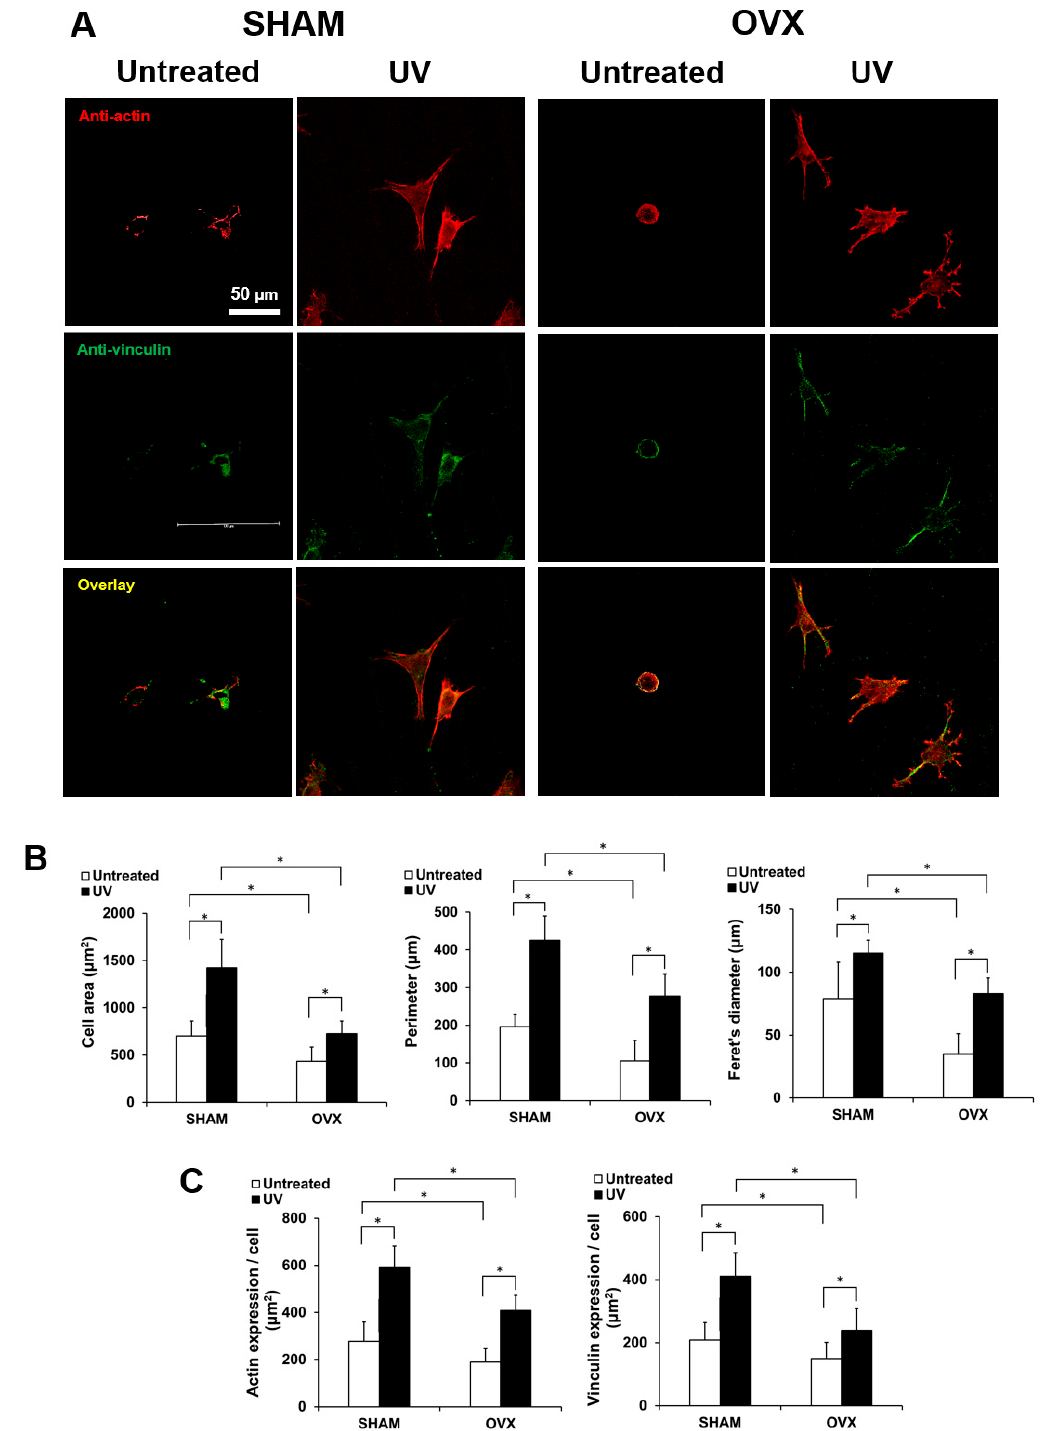
Figure 3. Representative confocal microscopy images of the spreading behavior of osteoblasts from sham and OVX groups at 24 h after seeding on untreated and photofunctionalized titanium surfaces. ( A ) Confocal microscopic images of osteoblast following immunochemical staining for cytoskeletal actin and adhesion protein vinculin are shown. Scale bar = 50 µm. ( B ) Histograms for cytomorphometric parameters measured from the images. ( C ) The expression levels of actin and vinculin were semiquantified using the confocal microscopy images. Data are mean ± standard deviation from triplicate experiments ( n = 3). * p < 0.05, significant between untreated and photofunctionalized surfaces.